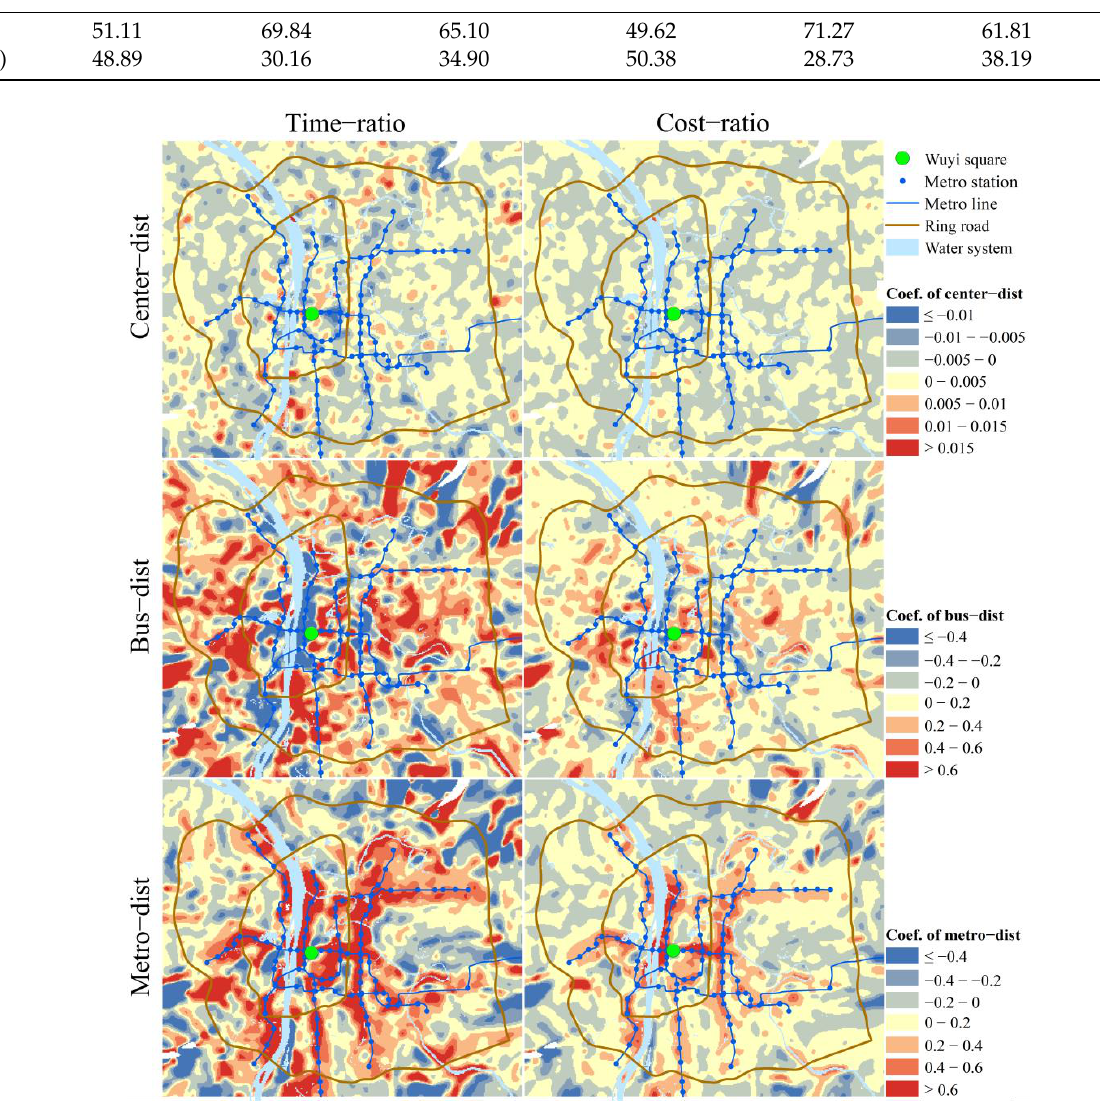
Figure 10. Mean coefficient of metro-dist for units within the same range from the metro stations.